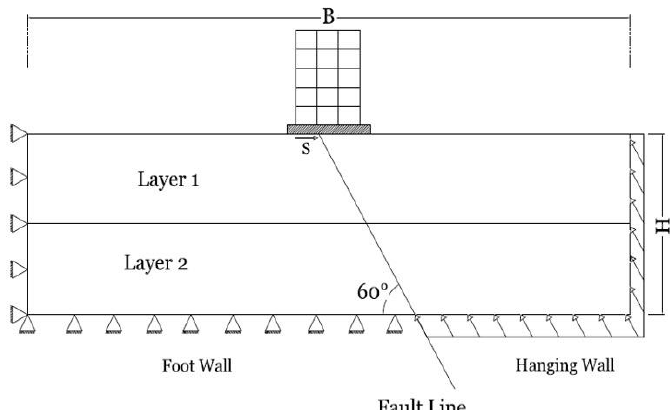
Fig 4. Schematic of model with dimensions and boundary